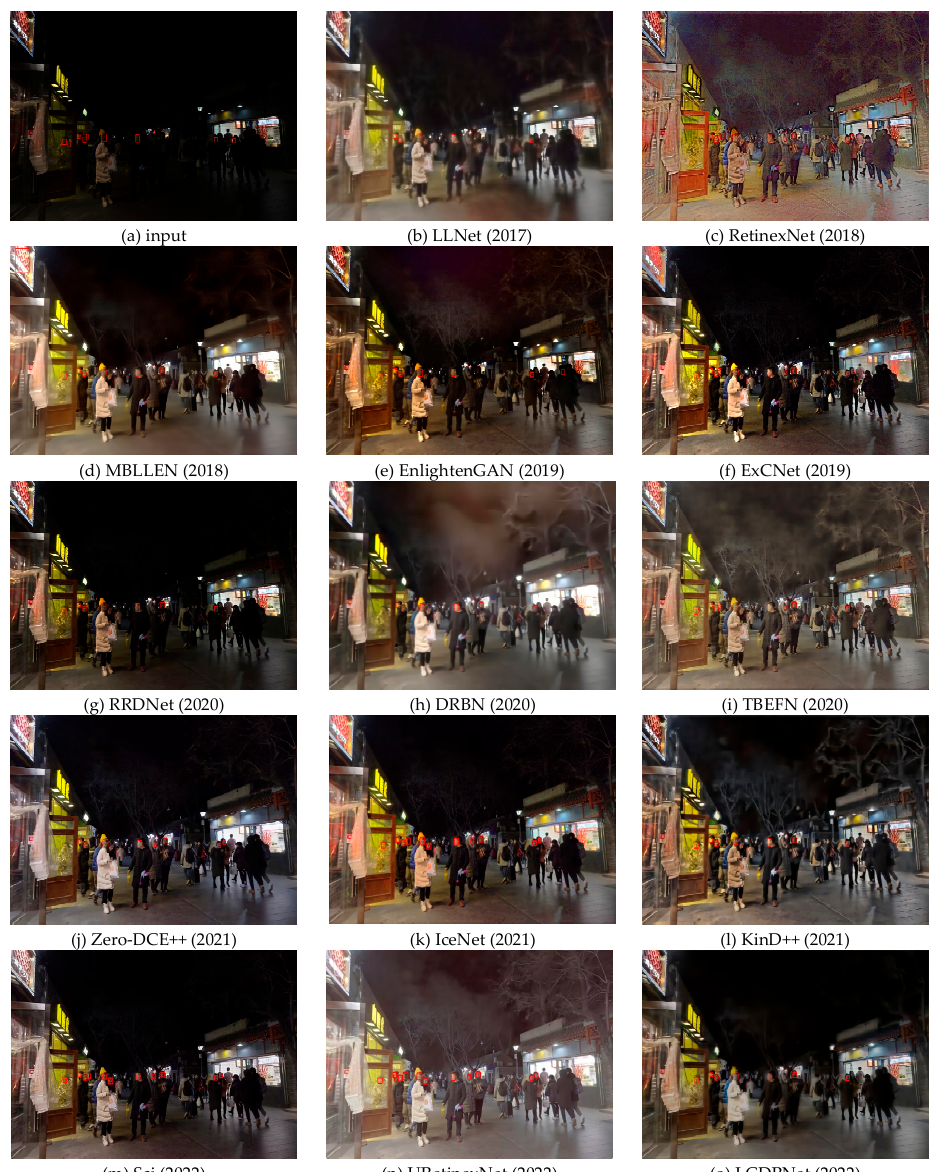
Figure 11. Low-illumination face detection visualization results.